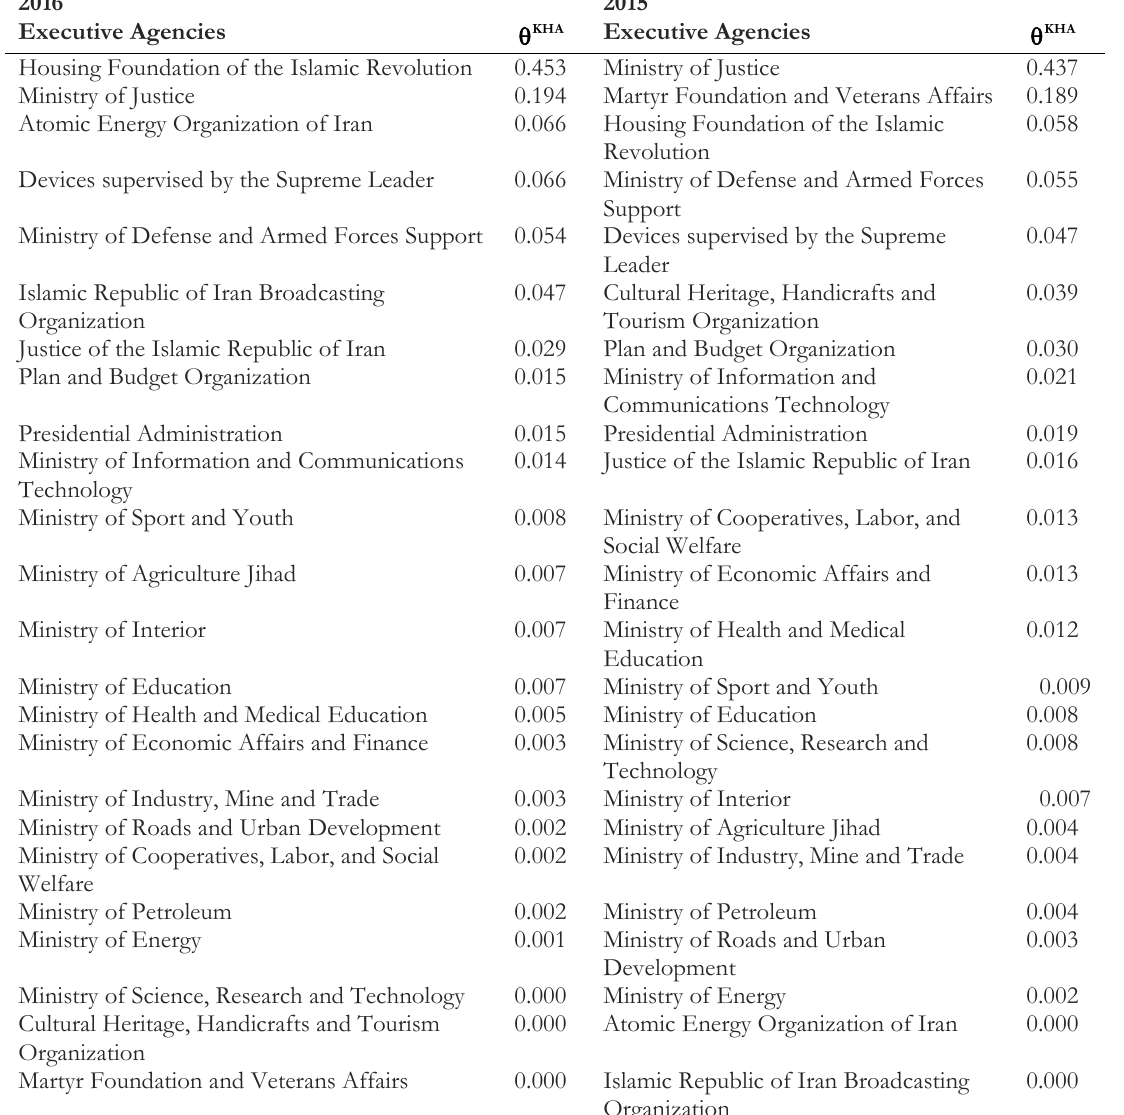
Table 2. Results relative to 2016 and 2015.